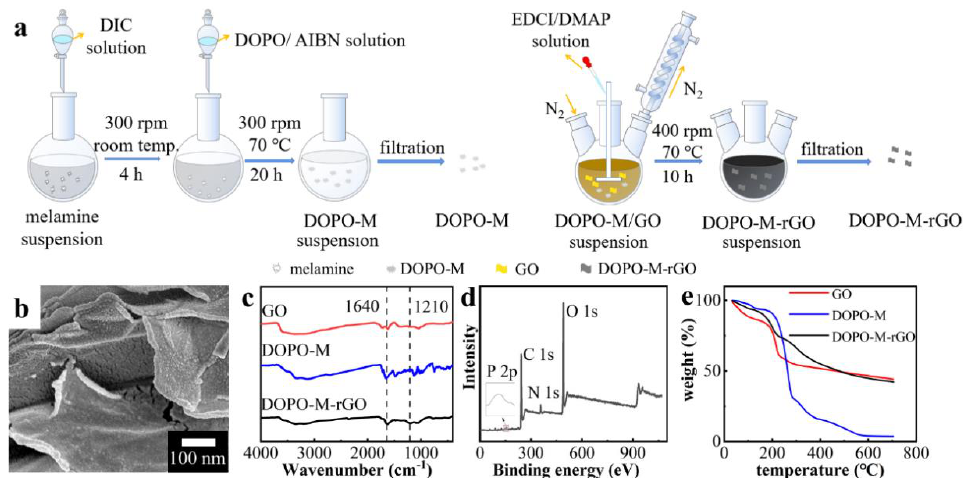
Figure 2. ( a ) Schematic representation for the preparation of DOPO-M-rGO; ( b ) SEM images of DOPO-M-rGO; ( c ) the FTIR spectra of GO, DOPO-M, and DOPO-M-rGO; ( d ) the XPS spectra for DOPO-M-rGO; ( e ) the TGA curves of GO, DOPO-M, and